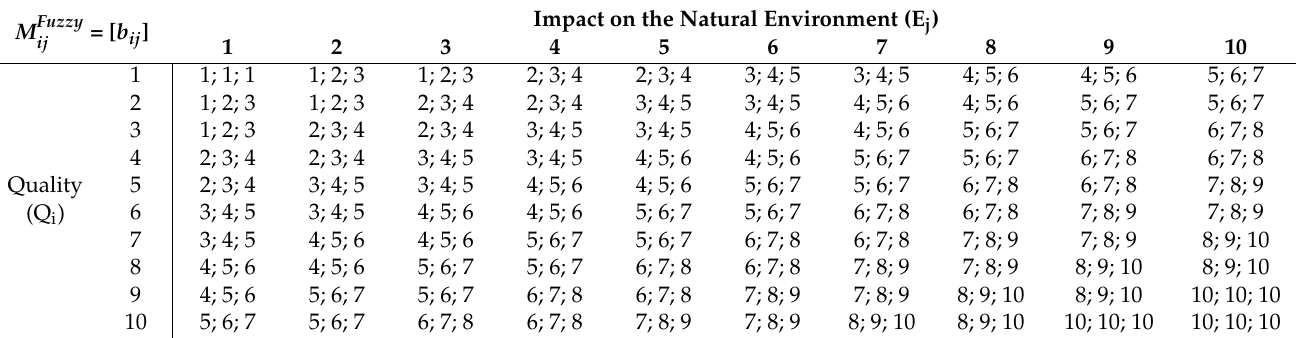
Table 7. Quotient of the sum of assessments and two cumulative assessments of quality and environ- mental impact expressed in triangular fuzzy